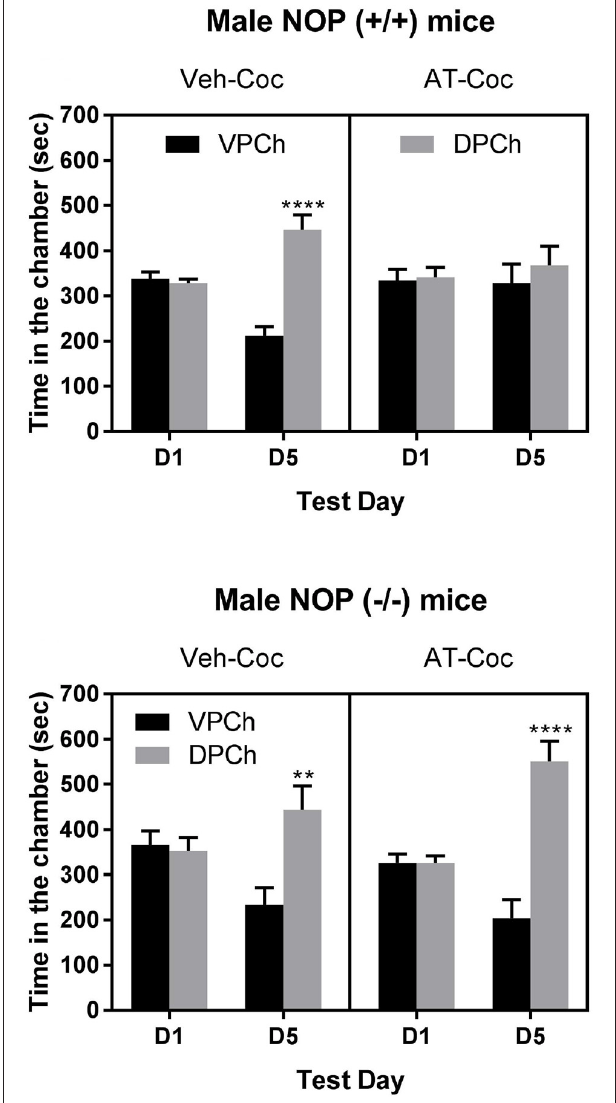
FIGURE 3 | Effect of AT-312 on cocaine-induced CPP in wild-type ( Upper ; n = 13 mice per treatment) or knockout ( Lower ; n = 10 mice per treatment) mice. Data are mean ( ± SEM) of the amount of time that mice spent in the vehicle-paired chamber (VPCh) and drug-paired chamber (DPCh) on the preconditioning (D1) and postconditioning (D5) test days. ** P < 0.01; **** P < 0.0001, a significant increase in the amount of time that mice spent in the DPCh vs. its respective VPCh on